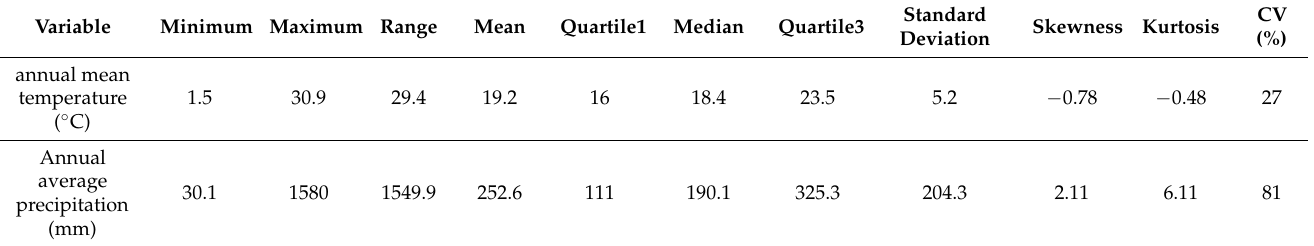
Table 1. Descriptive statistics of the annual mean temperature and annual average precipitation of Iran from 2002 to